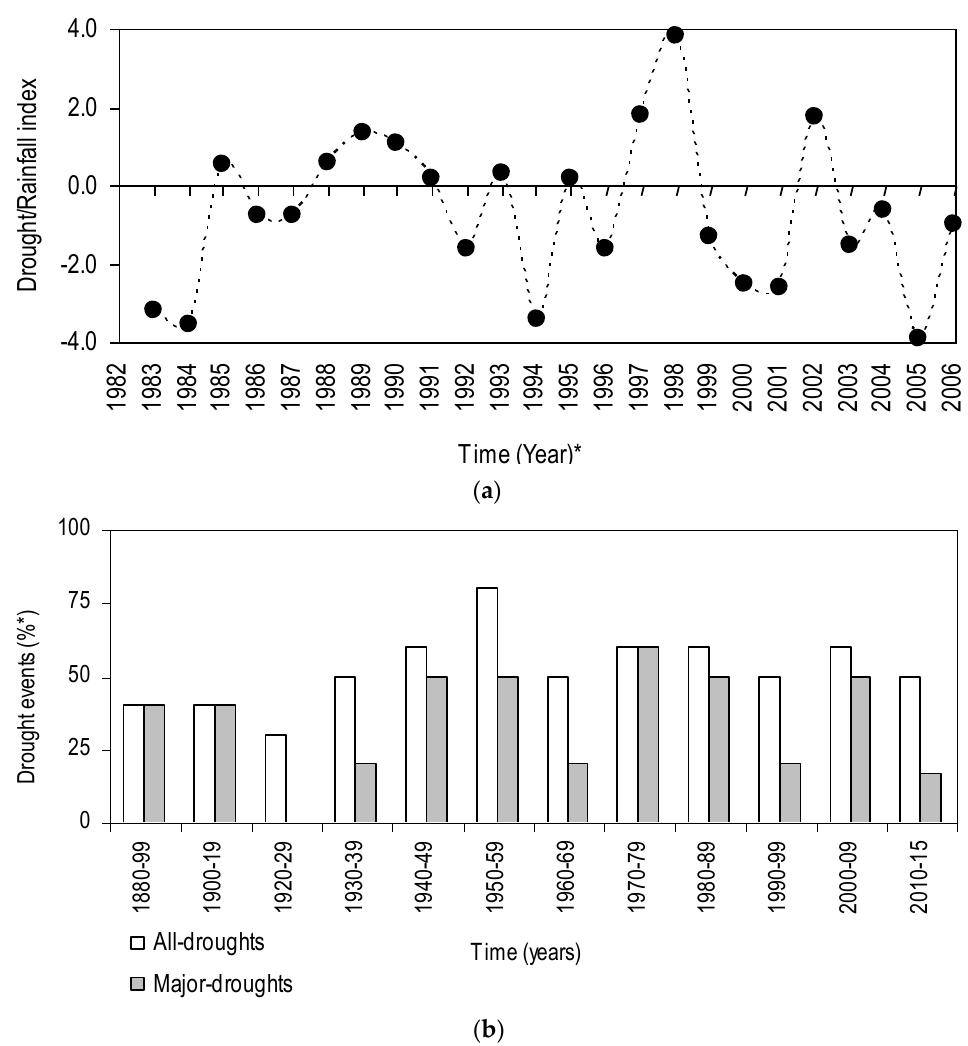
Figure 2. ( a ) Annual drought/rainfall trend for Kajiado based on standardized index. The region bounded by values (−1)–(+1) denotes the normal condition, while above and below it, respectively, symbolize a wet, flooded situation and dry, extreme drought conditions. Contrast: temporal = p < 0.05, spatial = p < 0.01. ( b ) Chronicles of drought occurrences for Kajiado District ( N = 176 ). This sample was drawn from documented events from diverse publications and datasets (print mass media, grey literature, and academic/scholarly). * Drought events/decade. Pre-1960s records are scant and scattered; post-1960 records are complete and widely available. Consecutive drought events (years, with